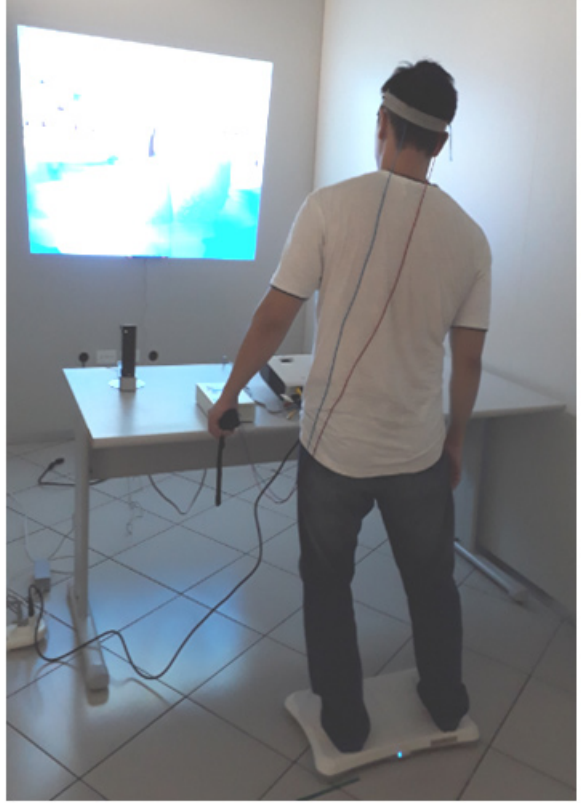
Figure 2. Positioning the participant on the board for the execution of the therapy with Nintendo Wii associated with active stimulation or sham. Source: author’s own, consent received for